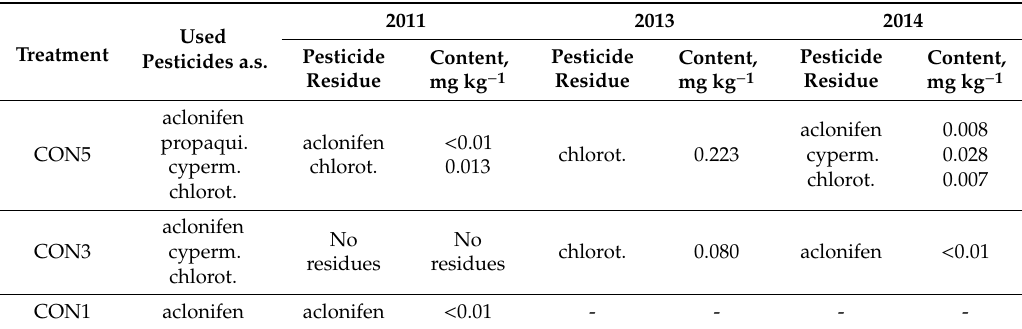
Table 4. Pesticide active substances, found in conventionally produced carrots.